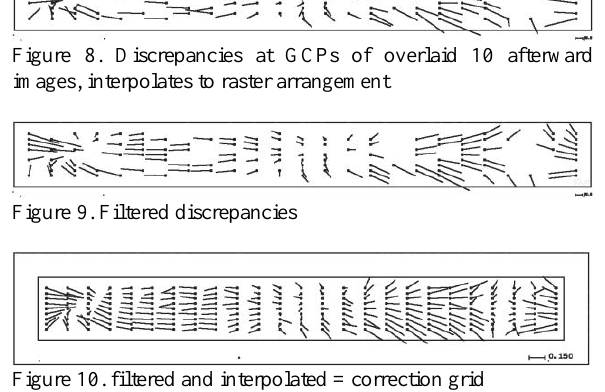
Figure 10. filtered and interpolated = correction grid The 720 residuals were averaged in 25 x 10 image sub-areas (figure 8) and filtered in order to reduce the influence of individual GCPs caused by limited accuracy of some GCPs (figure 9). Gaps in the correction file are interpolated by linear adjustment in the column direction and by linear interpolation of neighboured values in row direction (figure 10). This common correction grid for the afterward camera improved the resections by approximately 22% to SX=23m and SY=11m. In accuracy with SX=17m and SY=10m is slightly better than in